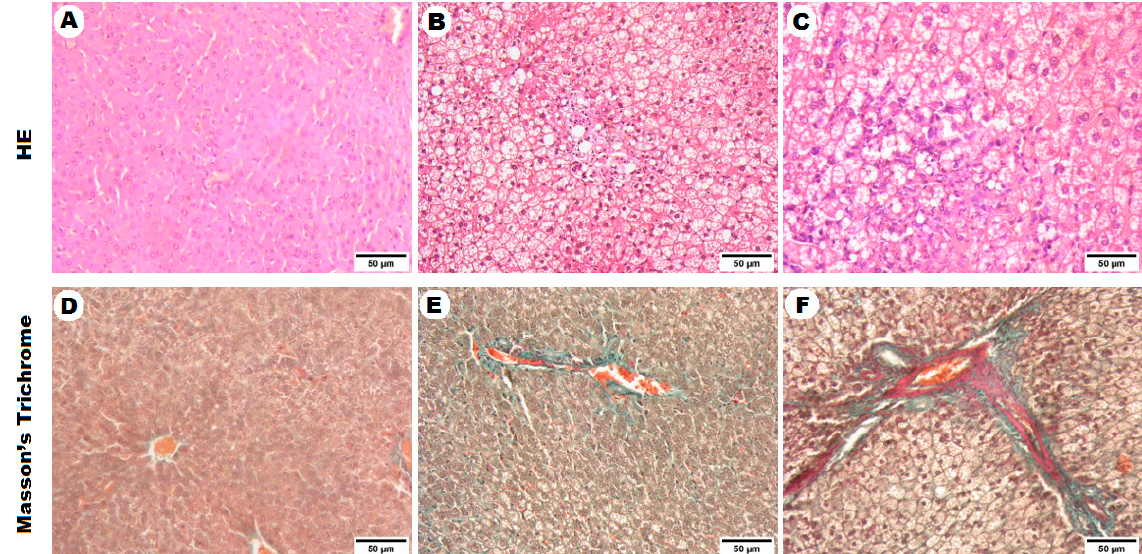
Figure 3. Histopathological changes in liver tissue of the experimental groups using HE and Masson’s Trichrome stains. ( A , D ) sections from NC group exposed to normal pellet diet; ( B , E ) sections from SS group exposed to HSHF for nine weeks; ( C , F ) sections from NASH group exposed to HSHF for 12 weeks (magnification: 200×). NC, Naïve control group; SS, simple steatosis; NASH, non-alcoholic steatohepatitis; HSHF, high sucrose high fat diet; HE, hematoxylin and eosin staining.